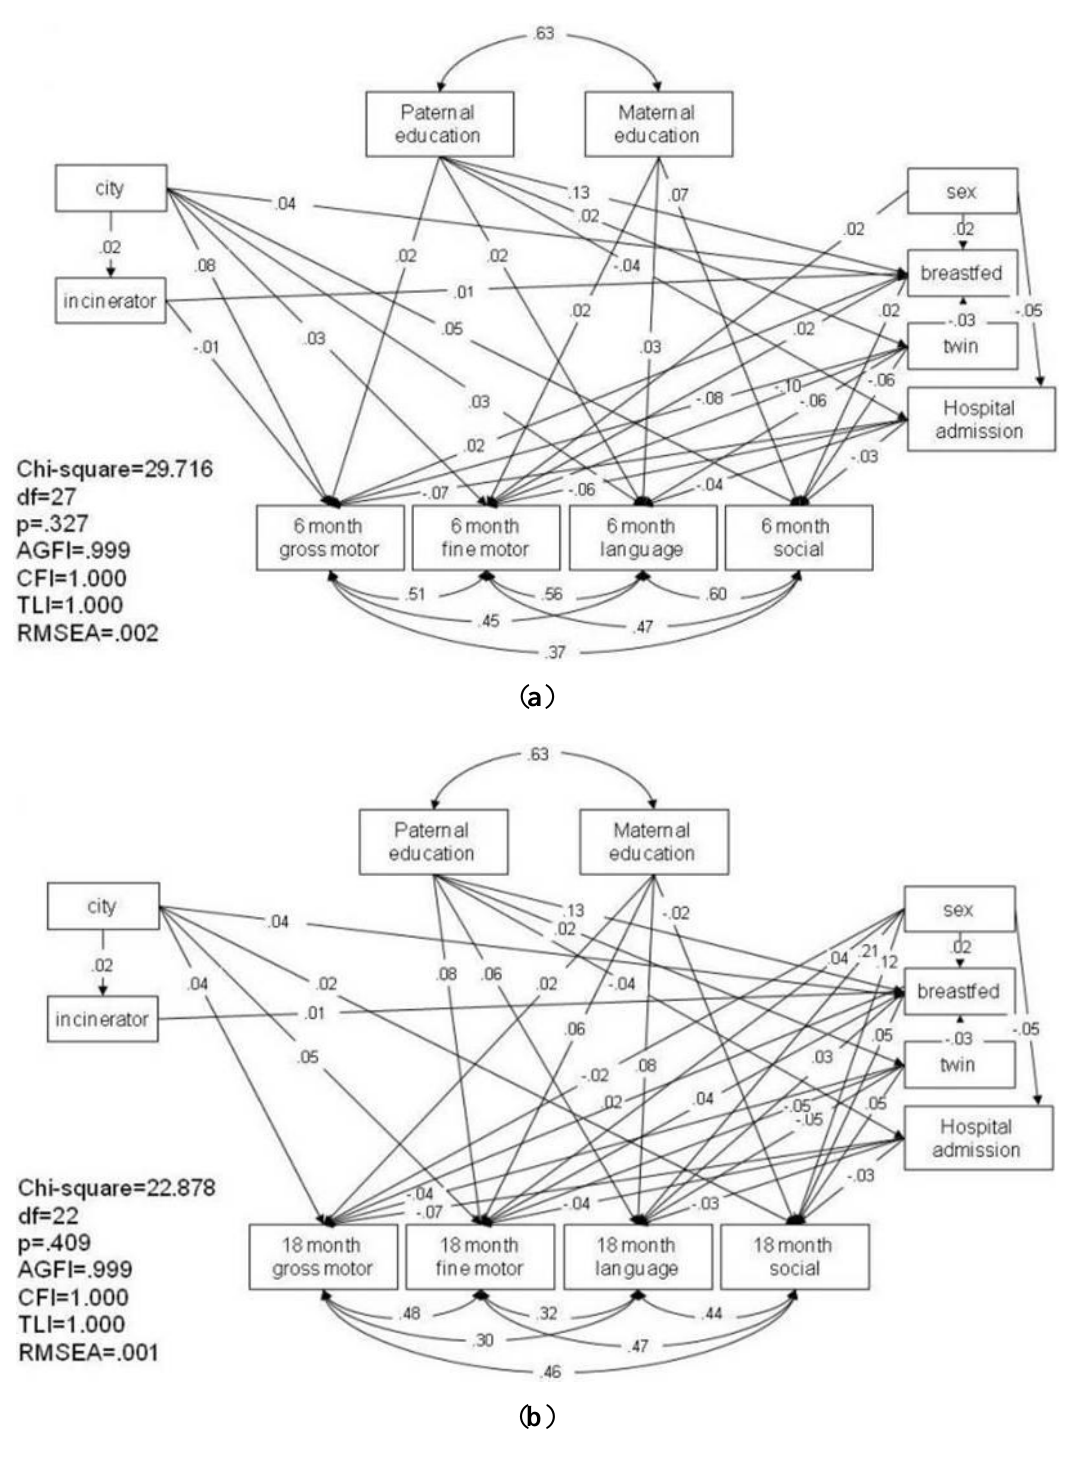
Figure 2. Parsimonious pathway analysis models of the relationship pathways among parental level of education, place of residence, living near an incinerator, breastfeeding, hospital admission and child development at ( a ) six months, ( b ) 18 months and ( c ) 36 months of